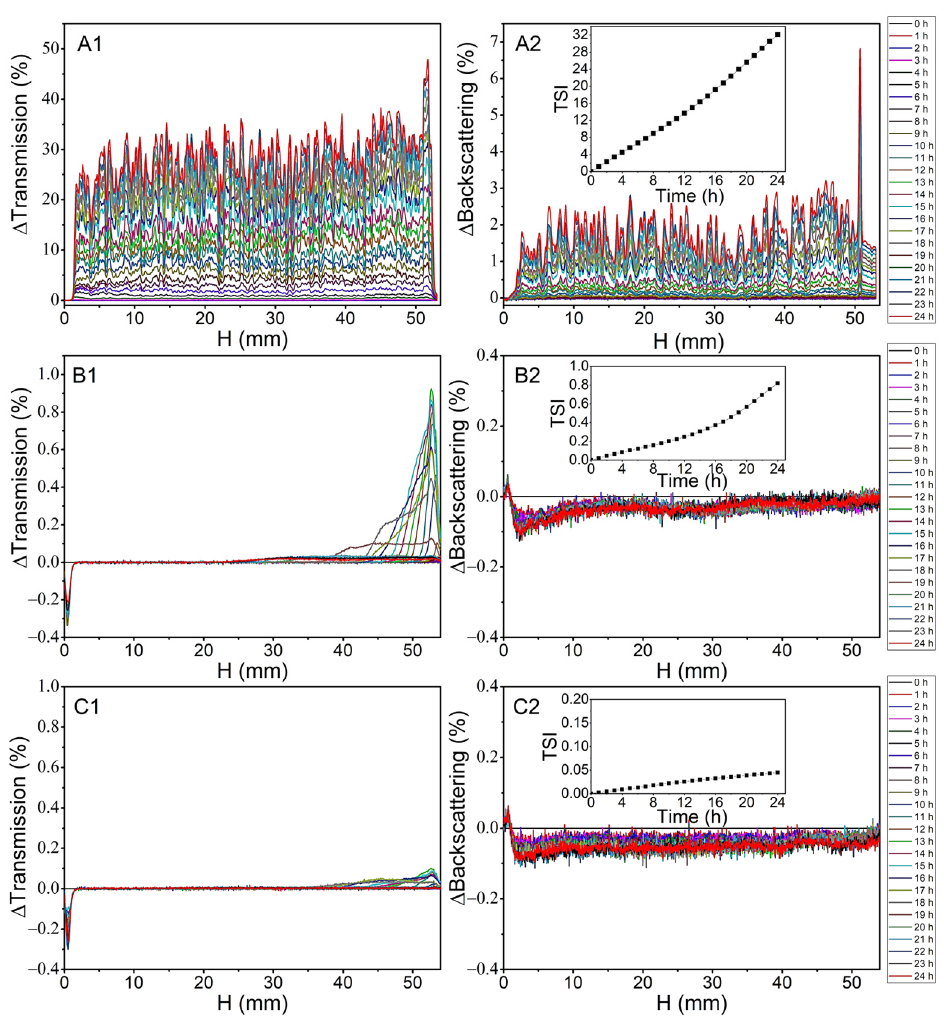
Figure 7. Δ Transmission and Δ Backsca tt ering of GN ( A1 , A2 ), GN–CU ( B1 , B2 ) and GN–CE ( C1 , C2 ) dispersion . ( C1 , C2 )